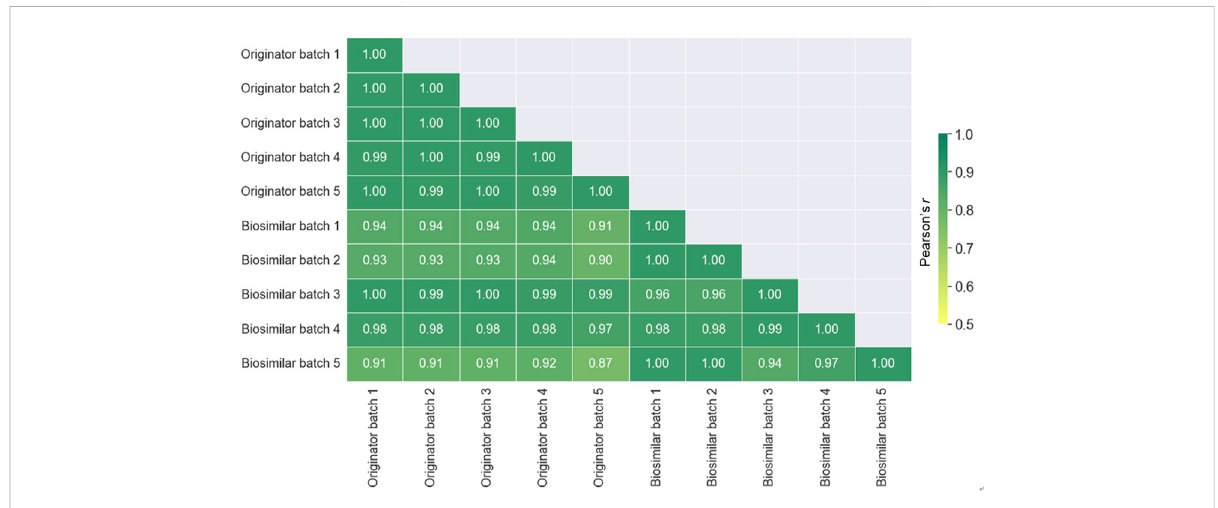
FIGURE 6 AHeatmapdisplaying thespectra similaritybetweentheoriginator (Remicade ® )andbiosimilar (Remsima ® )batches.The numbers displayed in the heat map represent the Pearson correlation coef fi cient